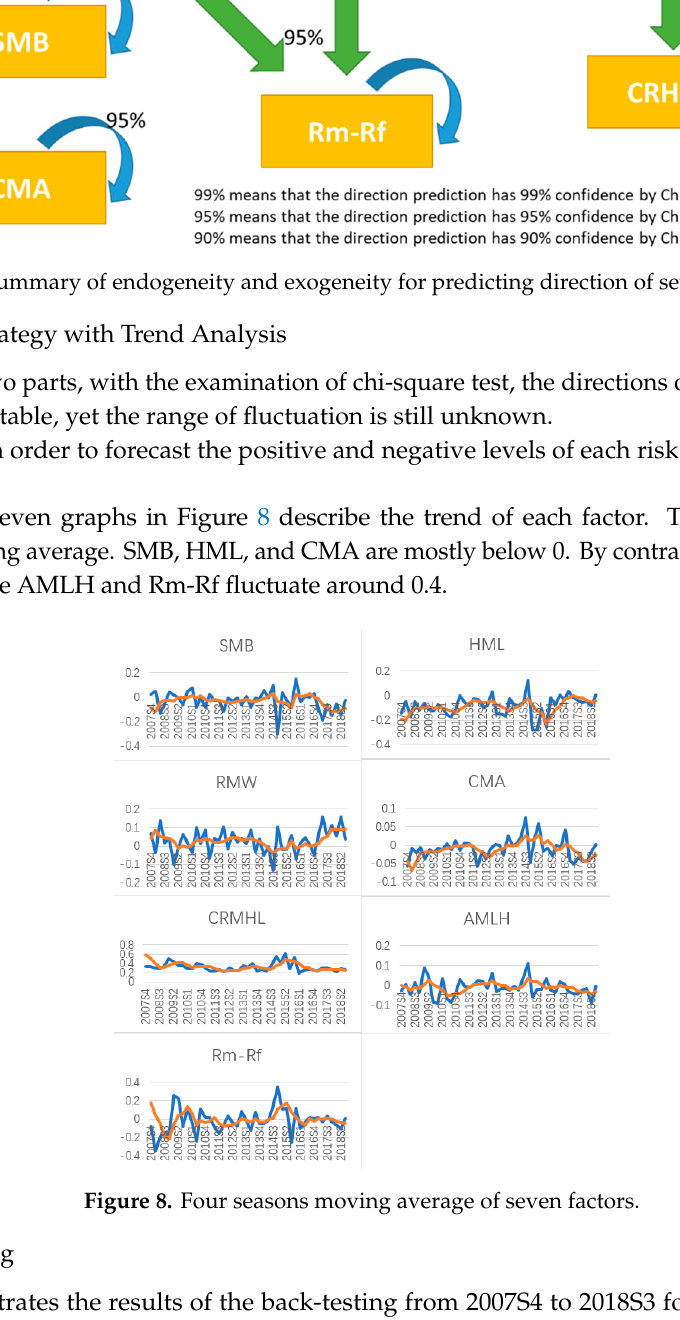
Table 7. Back-testing float return from 2007S4 to 2018S3 and expected annual return for factors. Factors